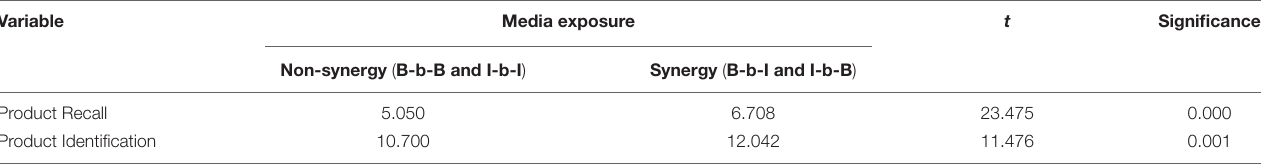
TABLE 3 | Comparison of non-synergistic stimulation and synergistic stimulation in the non-interference condition.